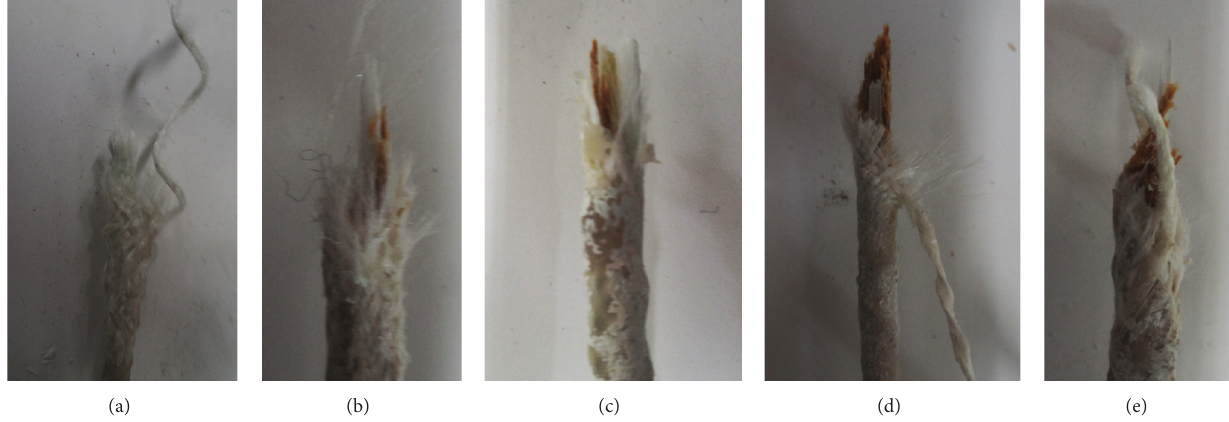
Figure 12: Fracture deformation of HGJFRP composite bar after tensile strength tests. (a) Jute fiber (0%). (b) Jute fiber (30%). (c) Jute fiber (50%). (d) Jute fiber (70%). (e) Jute fiber